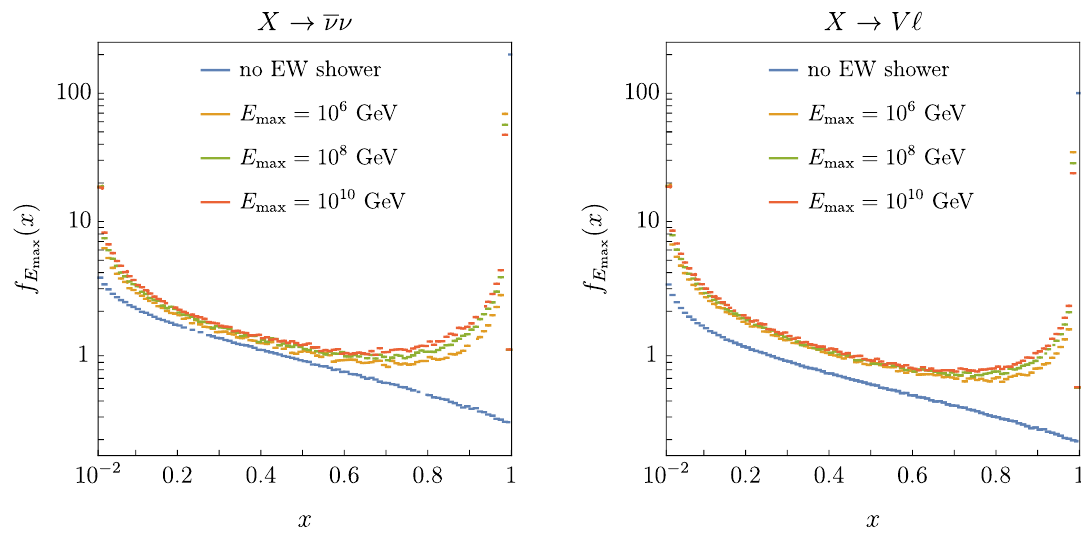
Figure 6 . The (cid:12)nal neutrino spectrum of decay model I and II considering EW showers at di(cid:11)erent energies. For comparison the spectrum without including EW showering is shown as well. The (cid:12)nal spectrum includes decays to neutrinos from any gauge bosons, taus and muons produced in the EW shower or in the primary decay. We can see that for higher COM energies the peak decreases, which demonstrates how more energy is distributed to EW